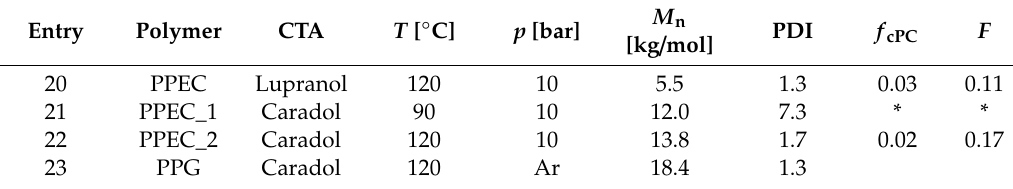
Table 4. Semi-batch PO homopolymerization and copolymerization with CO 2 .